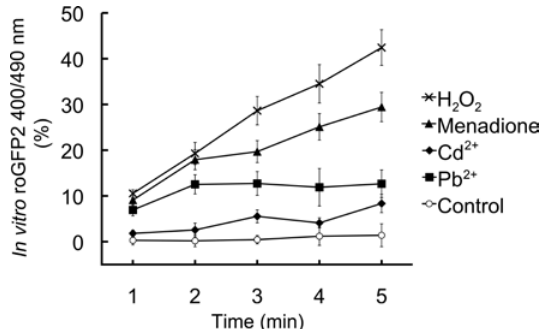
, 1 ppm Pb(CH COO) 2 3 2